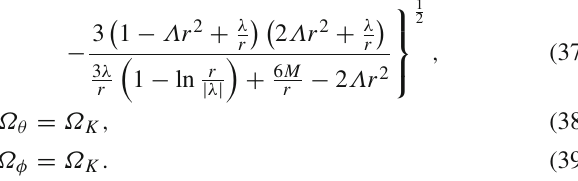
Figure 10 reflects the radial dependence of radial frequen- cies of test particles around the Schwarzschild black hole on the left panel and around the Schwarzschild–de Sitter black hole on the right panel for different values of dark matter λ . From Fig. 10, it can be seen that the radial frequency increases and location of oscillation shifts towards the left for small r due to the effect of dark matter. The inclusion of a cosmological constant does, however, cause the decrease of the frequency due to its cosmological